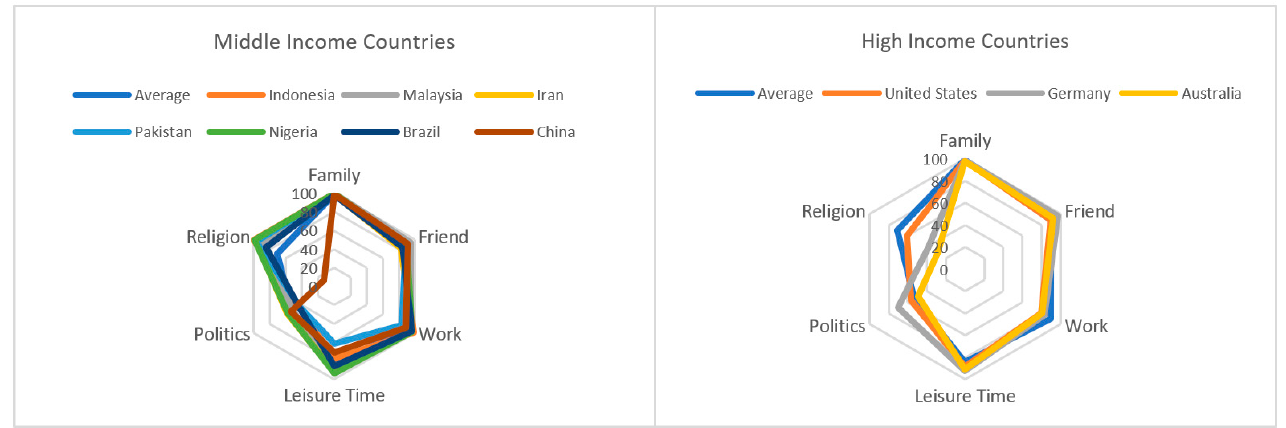
Figure 4. Important values in life by middle-income and high-income countries.